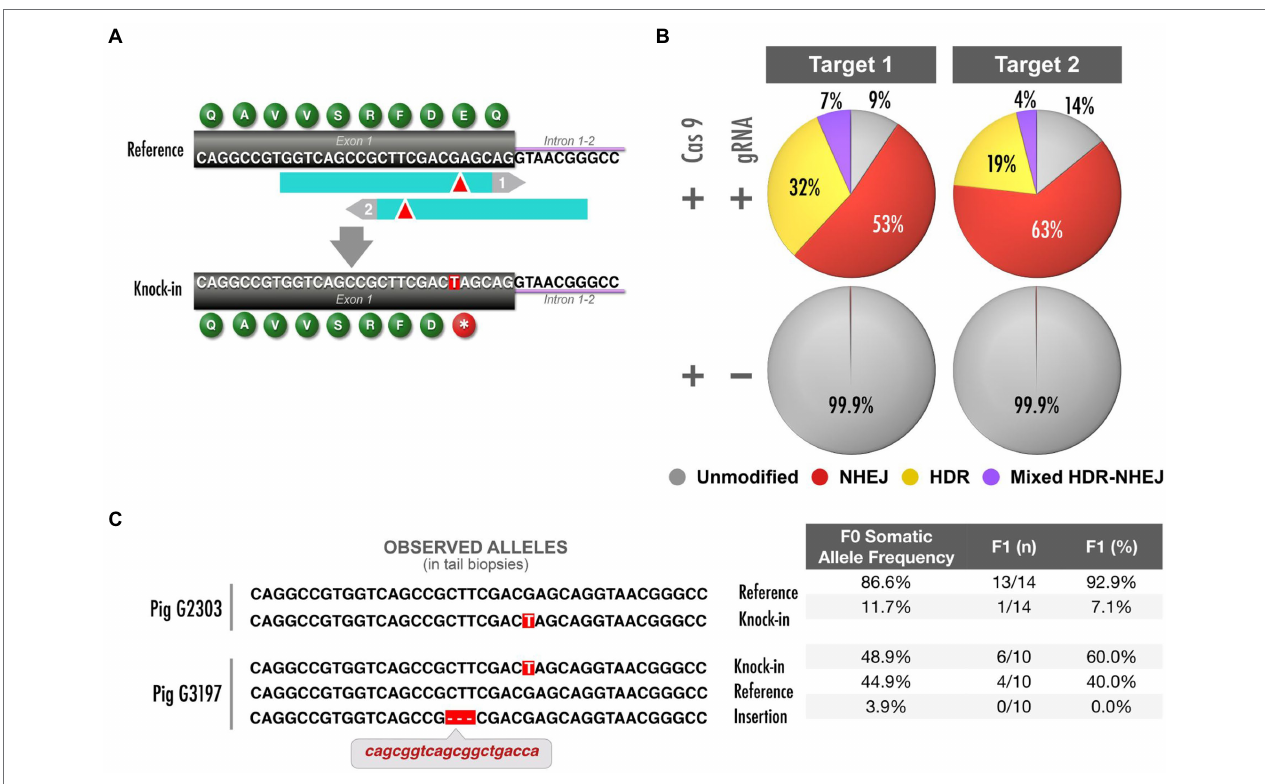
FIGURE 3 | NF1 early truncation model and analysis of mosaicism. (A) Top: schematic depicts NF1 exon 1 and two Cas9 target sites (blue, PAM in gray); donor oligonucleotides are not shown ( Supplementary Table 3 ). Bottom: precise G > T mutation generates an early truncation codon. (B) In vitro validation of targets shown in (A). Quantification of DNA repair products through TAm-Seq of amplicons and CRISPResso analysis. (C) Of four founders in total, two representative, validated founders were bred to generate a herd of E19 * F1 pigs. Left: allele sequences detected in somatic tail tissue from these founders (>1%). Right: Quantification of abundance of each allele and the proportion of sired F1 pigs that carry each allele from each founder. The pig with higher abundance of E19* in somatic tissue yielded a higher frequency of E19 * offspring (logistic regression, p <